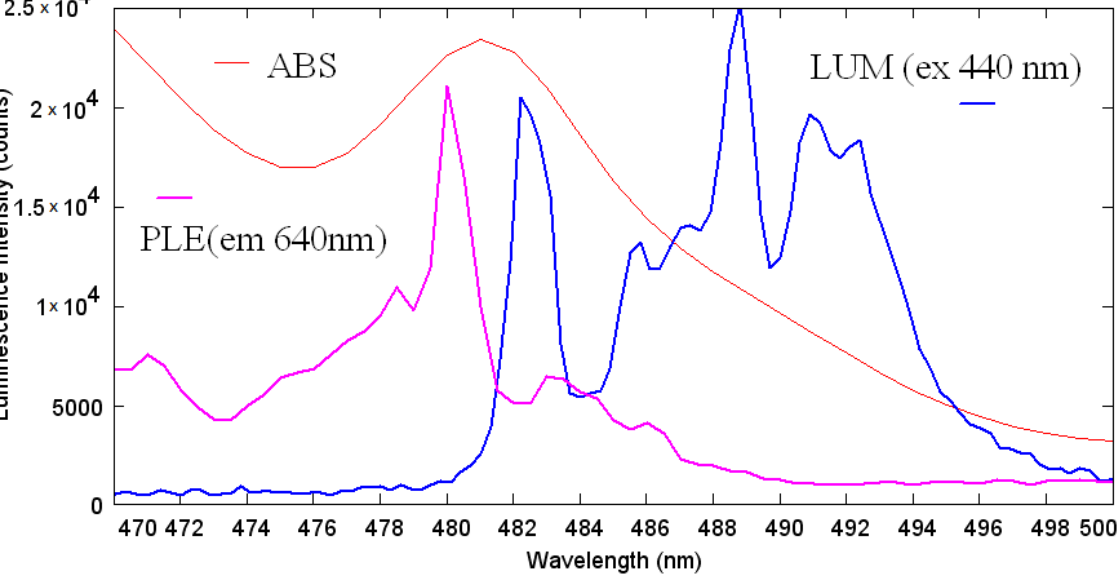
Figure 12. Excitation and emission spectra of Pr 2 (SO 4 ) 3 at 77 K. The absorption spectrum at room temperature is shown for comparison.